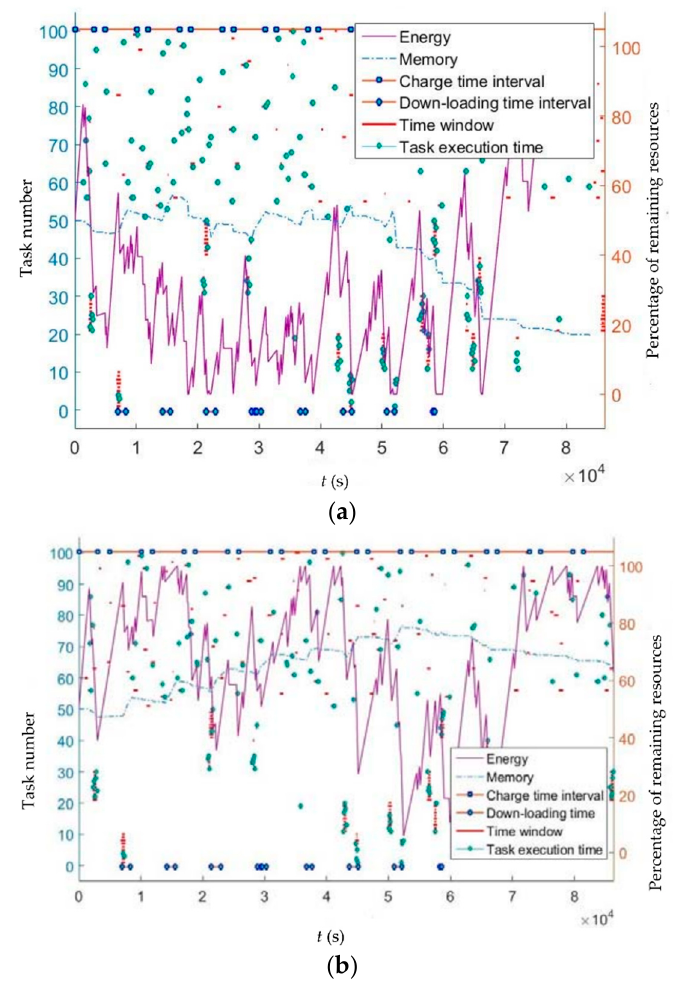
Figure 14. ( a ) Local task execution plan and ( b ) local task execution plan.